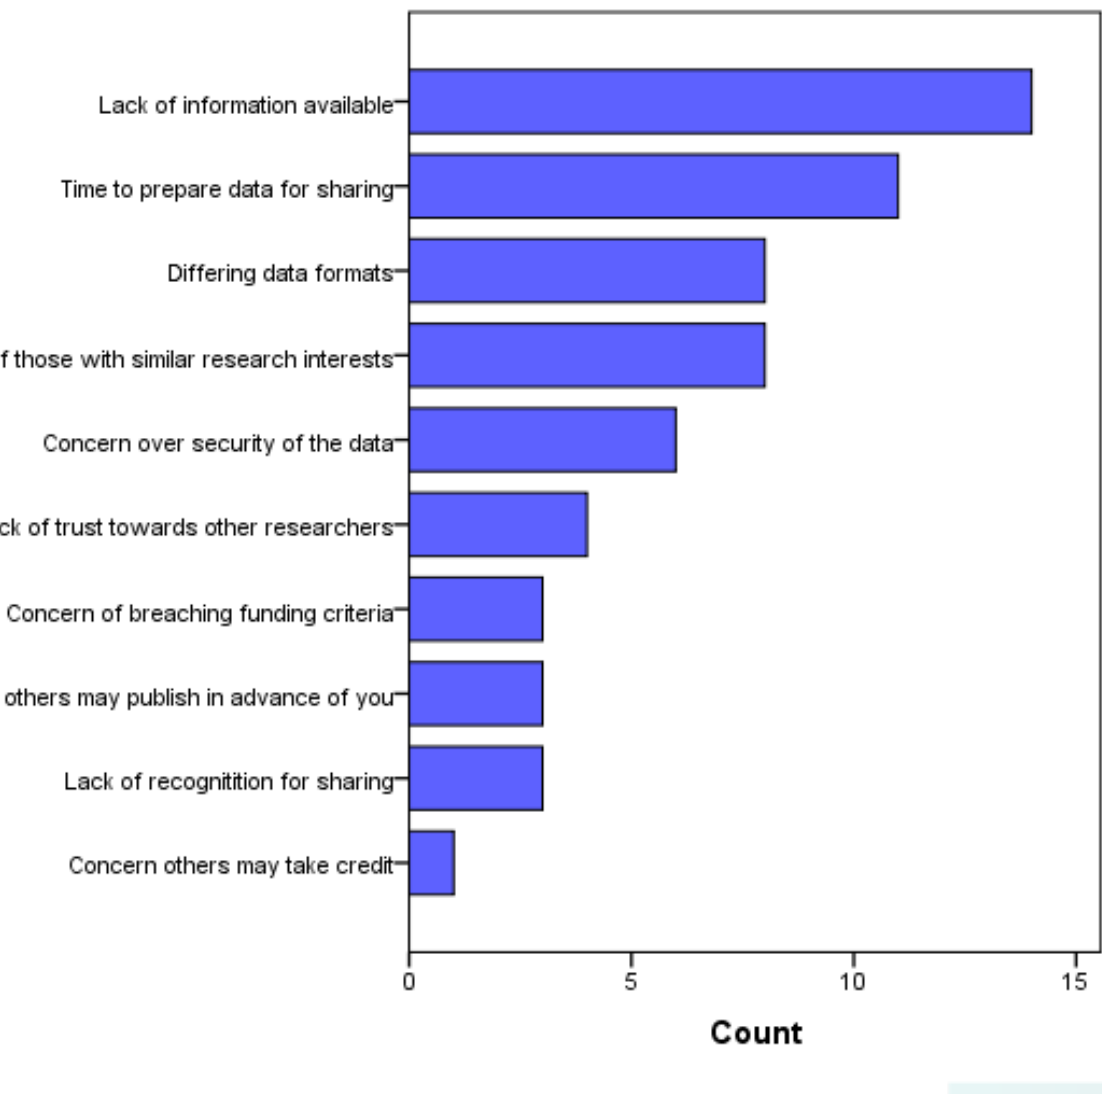
Figure 1: Ranked barriers to cross-centre